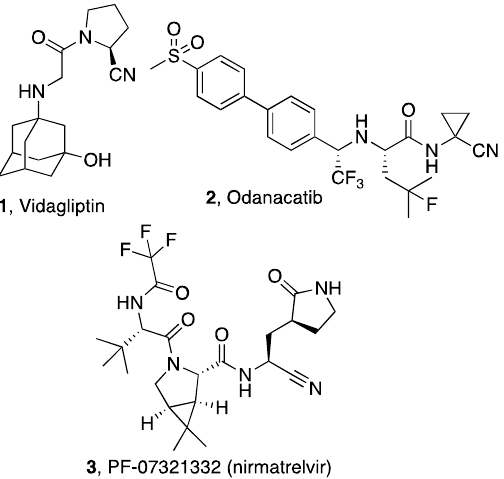
Figure 1. Structures of nitrile-containing drugs ( 1 , 3 ) and clinical candidate ( 2 ).